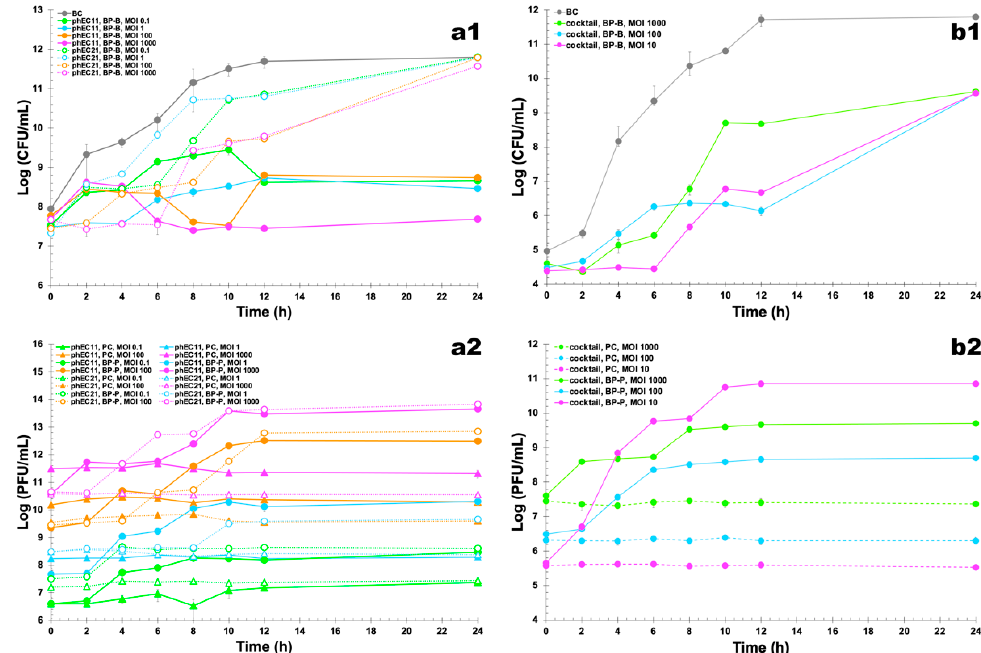
Figure 4. In vitro inactivation of E. coli by ( a1 ) independent phages vB_EcoM_Uniso11 and vB_EcoM_Uniso21 at a multiplicity of infection (MOI) of 0.1, 1, 100 and 1000, and by ( b1 ) their cocktail at MOI values of 10, 100 and 1000 during 24 h. ( a1 , b1 ) Bacterial concentration: BC, bacterial control; BP-B, bacteria with phage; ( a2 , b2 ) phage concentration: PC, phage control; BP-P, bacteria with phage. Values represent the mean of three independent assays whereas error bars represent the standard deviation.